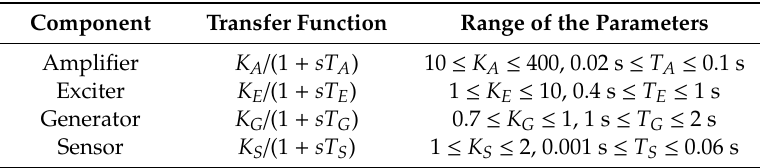
Table 1. Transfer functions of each AVR system component.